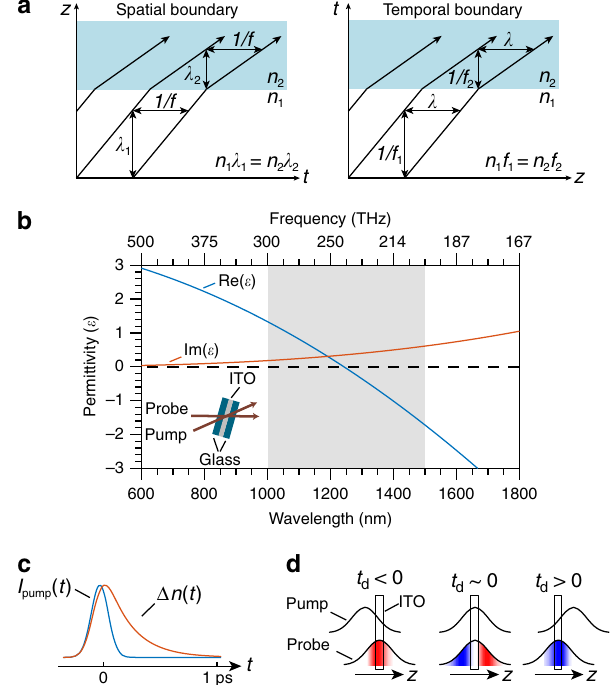
Fig. 1 Concept of time refraction. a A spatial boundary de fi ned by a refractive index change from n 1 to n 2 leads to a change in the wavevector of a light beam as it passes through the boundary and is described by n 1 λ 1 = n λ fi ned in time leads to time- 2 2 (left panel). A refractive index boundary de refraction effect of a light beam as it passes through the boundary and is described by n 1 f 1 = n 2 f 2 (right panel). Here f is the frequency of light waves in the medium. b The permittivity of an ITO fi lm used in the experiment. The inset shows the simpli fi ed experimental setup and the shaded region shows the spectral range of interest in this work. c Simpli fi ed illustration of the temporal index change Δ n ( t ) of ITO excited by a pump pulse. d The frequency of the probe redshifts (blueshifts) if the pump beam lags (leads) the probe. At near-zero delay both redshift and blueshift can